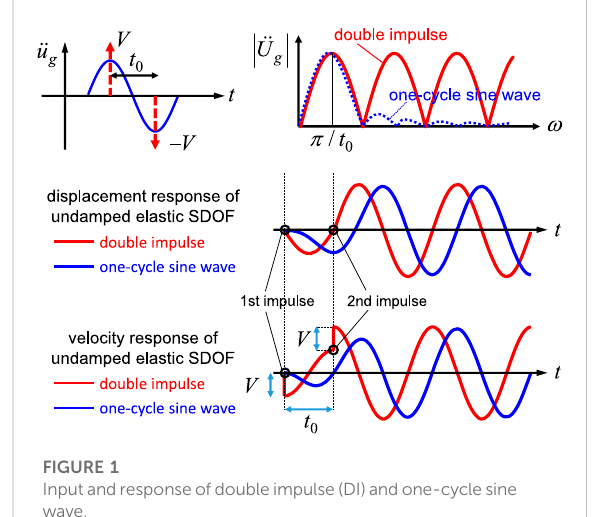
FIGURE 1 Inputandresponseofdoubleimpulse(DI)andone-cyclesine wave.